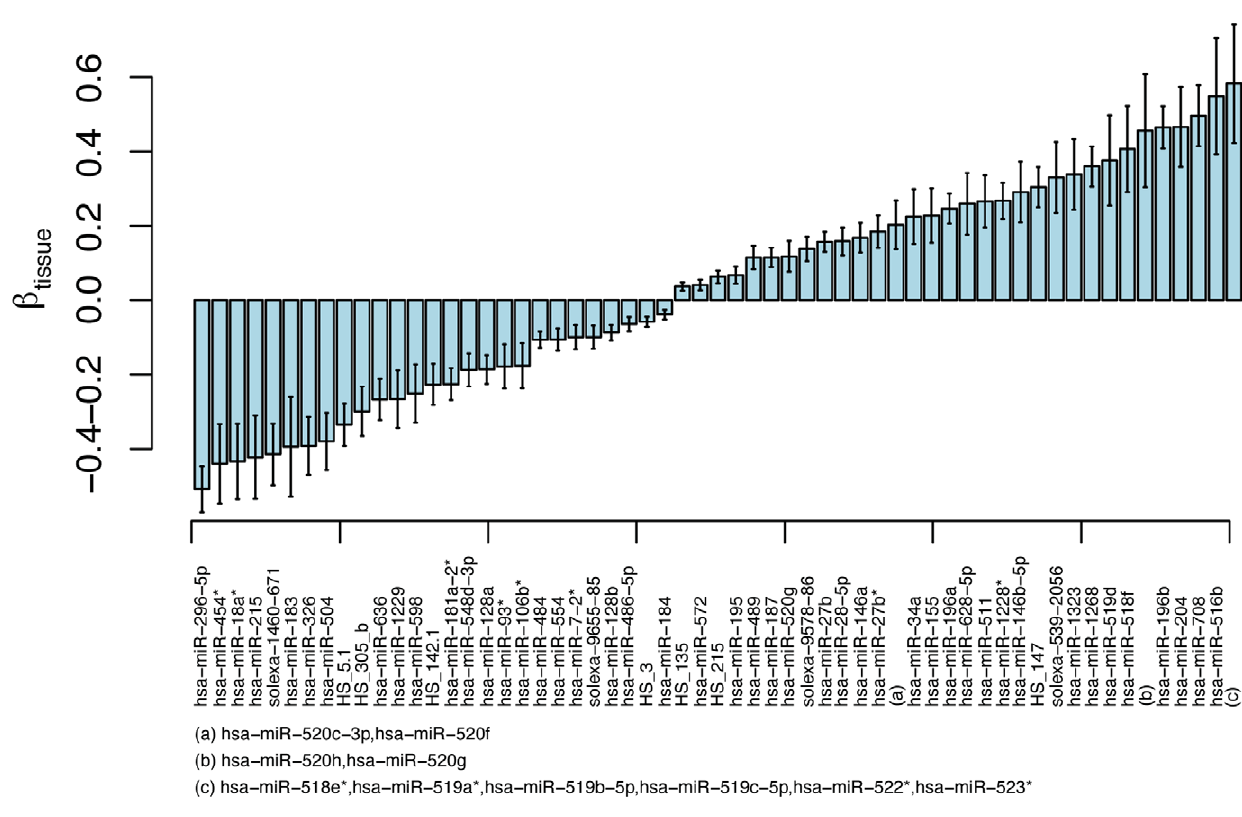
Figure 1. Tissue differential expression (the tissue-related fixed-effects coefficients ( b )), of the 59 miRNA that were replicated (p-value , 0.05) in the replication study. The coefficients ( b ) are sorted on effect-size, a positive value indicating higher expression in gluteal adipose tissue relative abdominal adipose tissue. Error-bars show the standard-error of b for each miRNA.